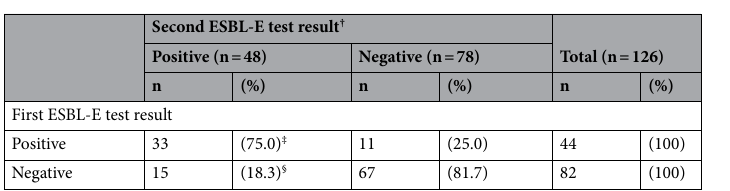
Figure 2. Lengths of positive ESBL-E carriage statuses among residents who underwent the second testing and third testing (n = 36; Analysis Part 3). † Performed 3–12 months after the first testing. ‡ Performed ≥ 12 months after the second testing. § Excluding 4 residents with positive results in the third testing. ¶ These two residents exceptionally underwent the third testing at 10 months after the second testing. ESBL-E, extended-spectrum β-lactamase-producing Enterobacterales.